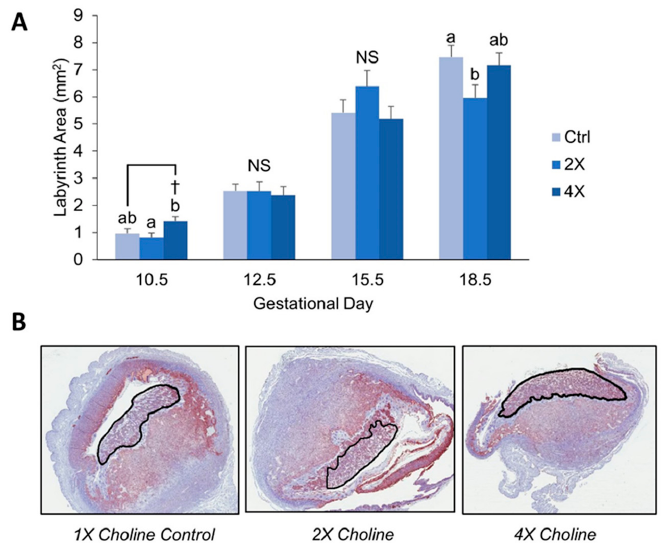
Figure 1 . Placental labyrinth area at E10.5, E12.5, E15.5, and E18.5 by choline treatment (A) . Representative images of placental labyrinths at E10.5 are shown in (B) . Data were analyzed using mixed linear models with choline treatment as a fixed effect and maternal ID as a random effect. Litter size, fetal genotype, and fetal sex were controlled for in the models as fixed effects. Values are presented as mean ± SEM. Different letters denote significant differences between means of the treatments at p ≤ 0.05. † denotes p < 0.1. n = 7–12 placentas per treatment per time point. NS, nonsignificant.